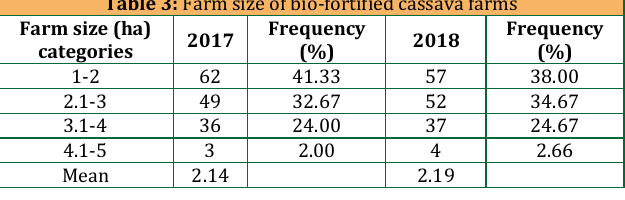
Table 4: Farm specific characteristics Variables